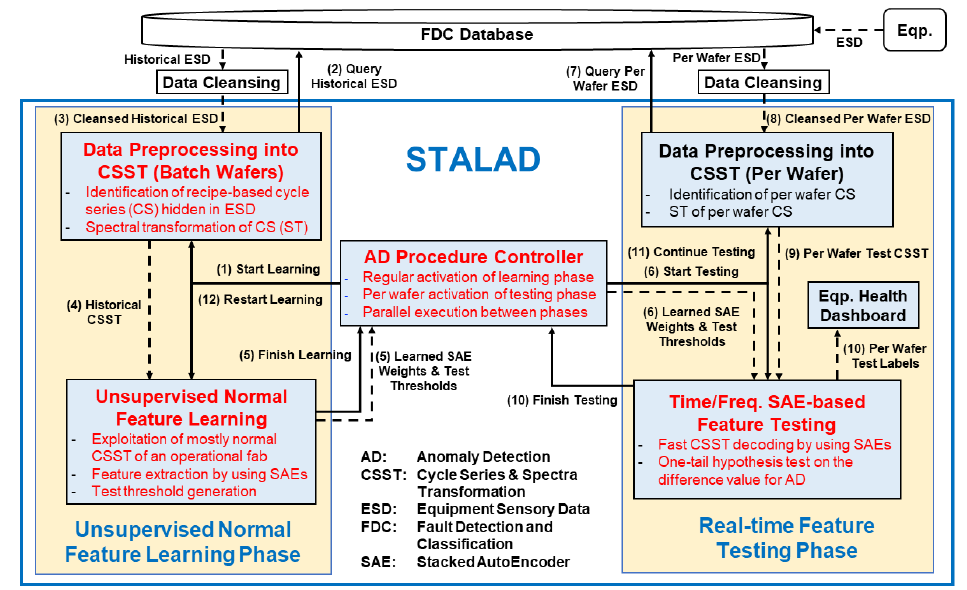
Figure 4. STALAD framework and operation procedure.